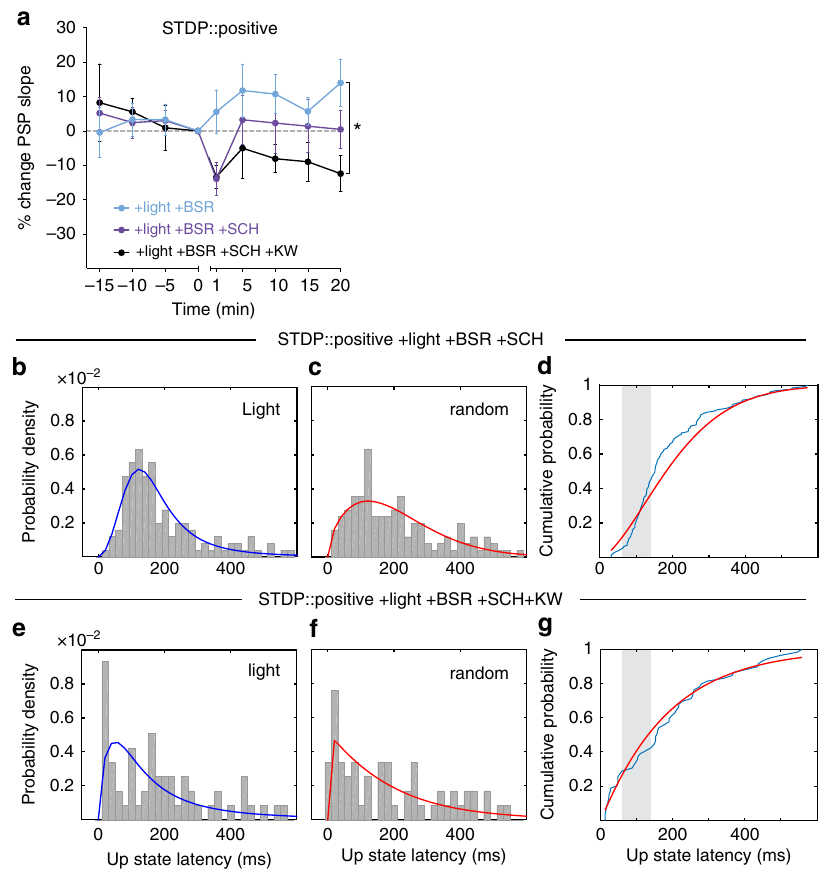
Fig. 4 The effect of the conditioned light stimulus on potentiation is mediated by dopamine D 1 and adenosine A 2A receptor signaling. a Systemic administration of SCH 23390 (+SCH, n = 6) partially abolished the potentiation previously found with the positive timing STDP protocol with reinforcement. Combined SCH 23390 and KW-6002 (+SCH +KW, n = 4) systemic administration resulted in robust depression of corticostriatal synapses in comparison to the reinforced positive timing group (LME, est. effect size = 18.5 ± 7.1%, F 1,9 = 6.69, * P = 0.02). Data presented as mean ± s.e.m. The PDFs for the +SCH group ( b , c ) and +SCH +KW group e , f were calculated with the same methodology outlined in Fig. 3. The light-evoked latencies for the +SCH group ( n = 124) were signi fi cantly different from, and hence unlikely to have been sampled from, the random latency distribution (Kuiper ’ s test, P < 0.00001); light-evoked latencies ( n = 58) were not signi fi cantly different in the +SCH +KW group (Kuiper ’ s test , P = 0.09). d , g In the +SCH group (+0.18), but not in the +SCH +KW group (+0.02), the light events showed a notable probability above chance of initiating an up